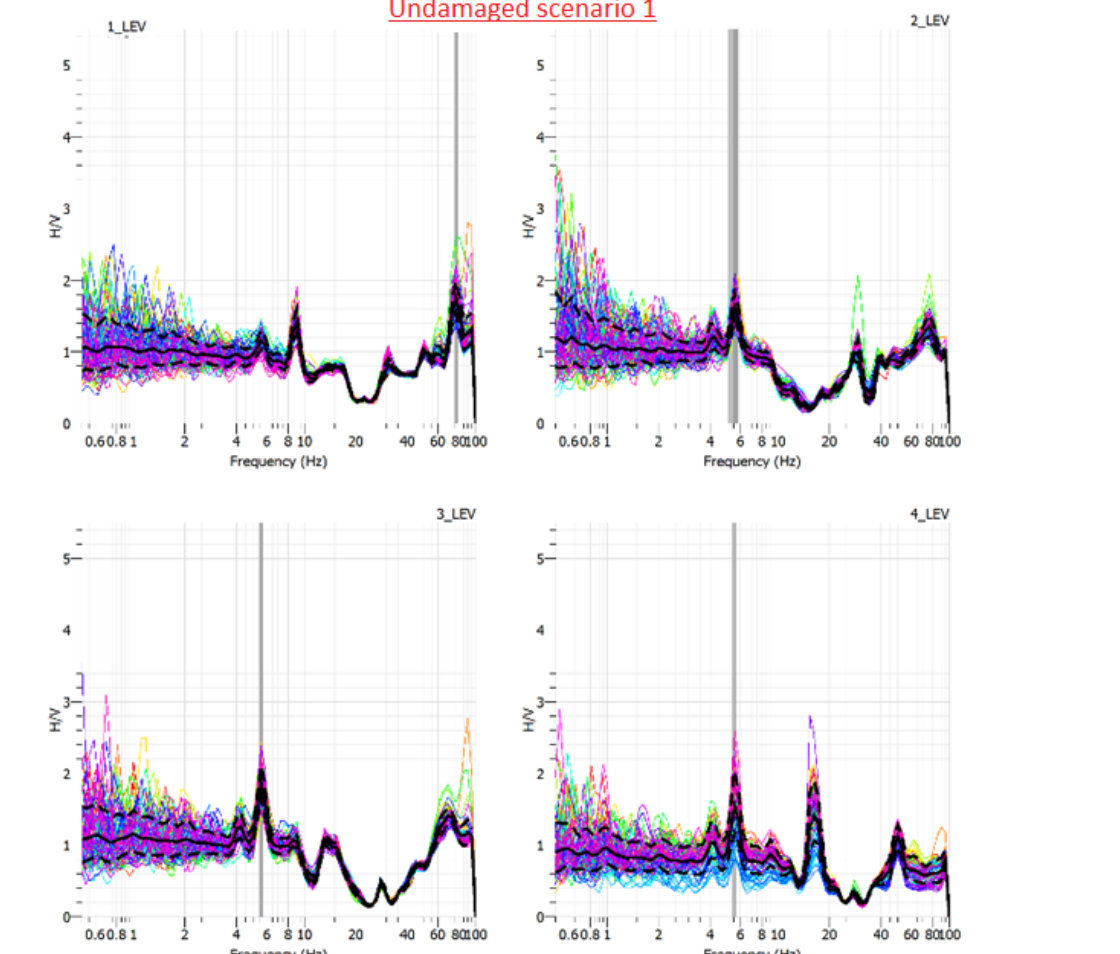
Figure 26. HVSR analysis of ambient noise recording, for undamaged scenario 1 of the metallic